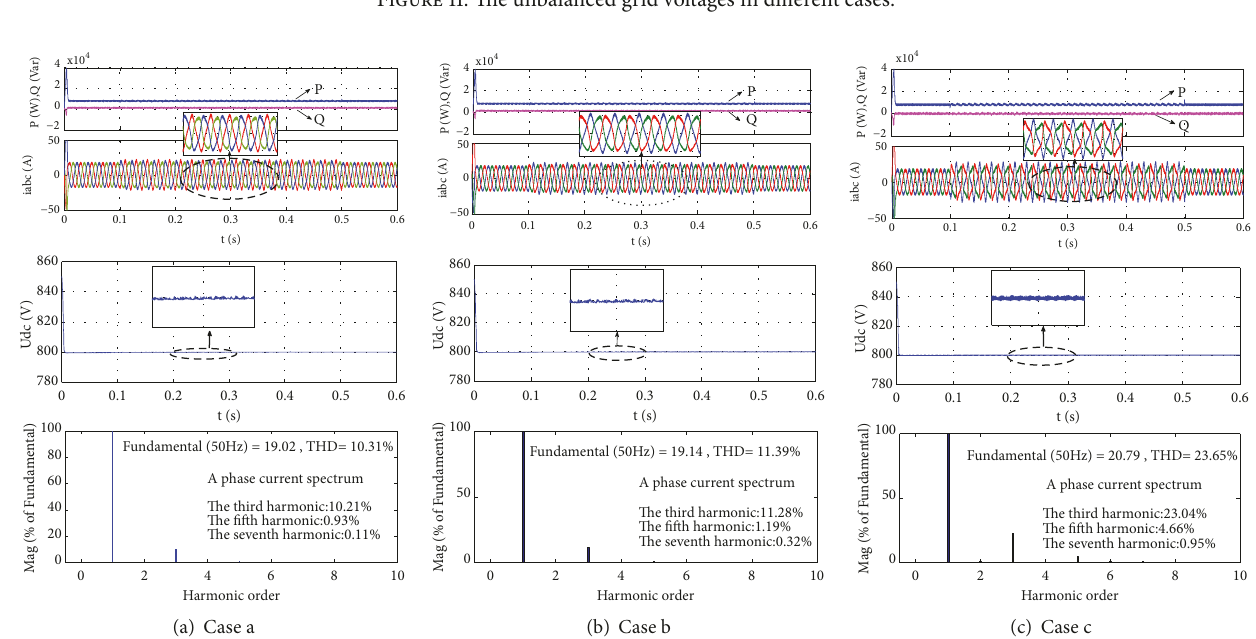
Figure 12: Simulation results of instantaneous power control strategy in different cases.